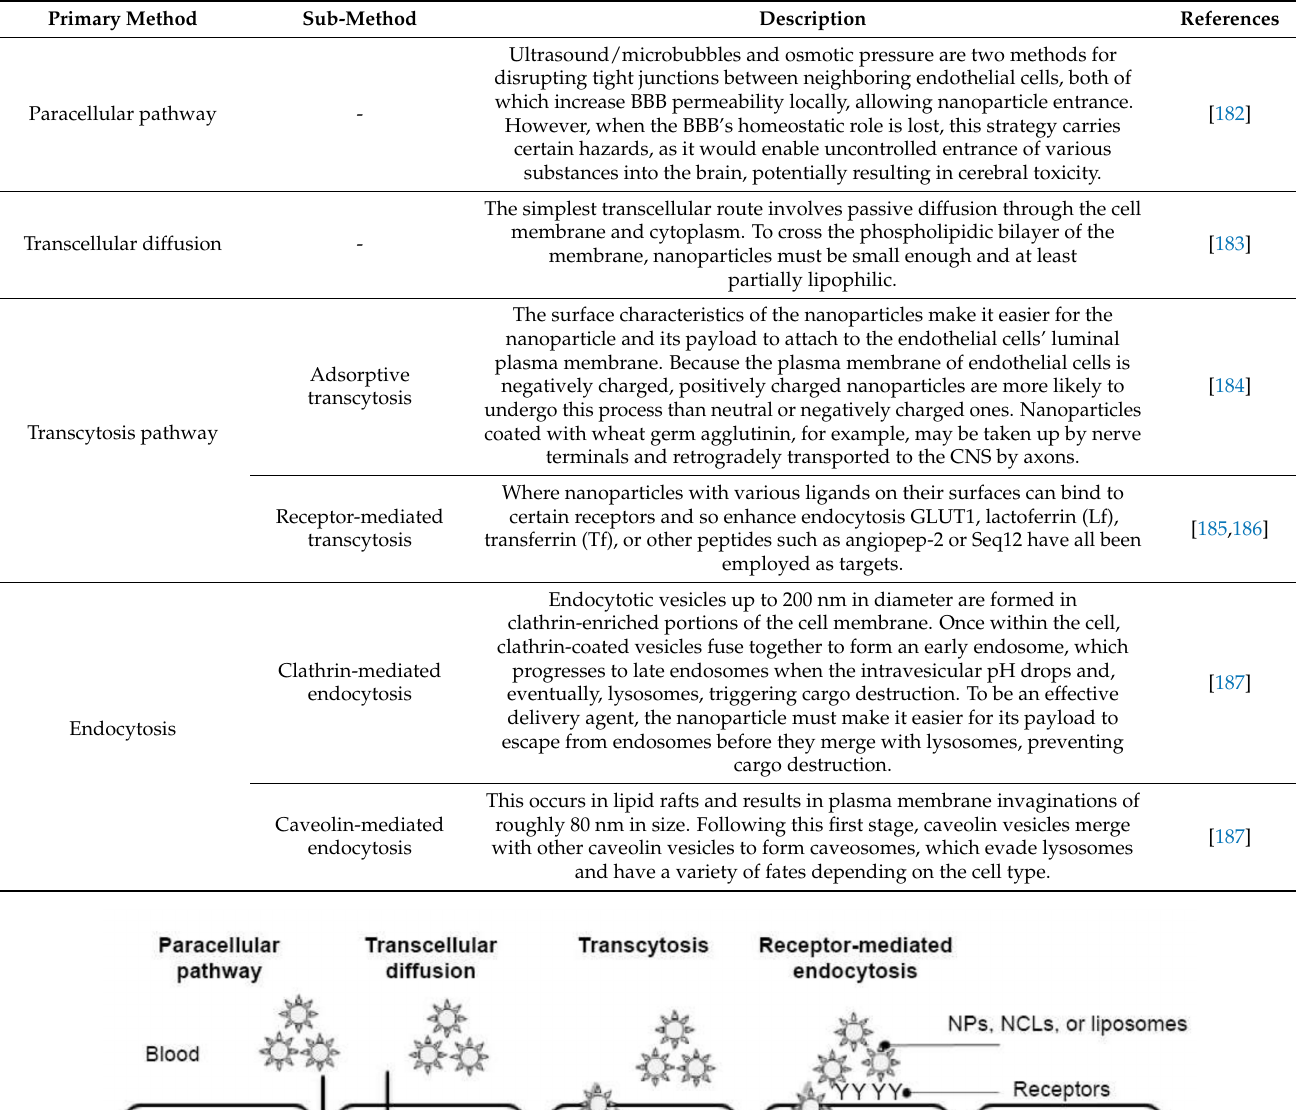
Table 2. Approaches for improving BBB crossing of nanoparticles.